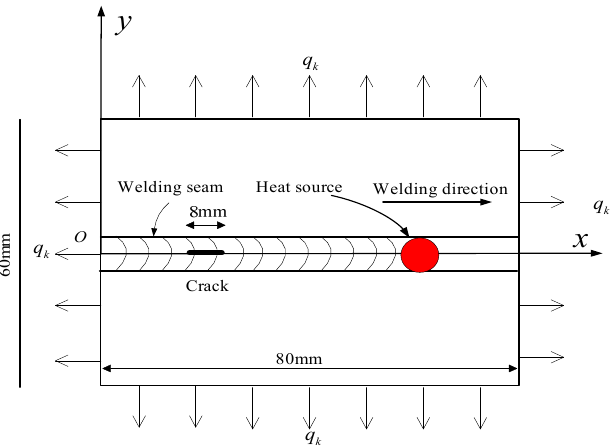
Figure 13. Geometry and boundary condition of the welding heating process with an inclined isothermal crack.